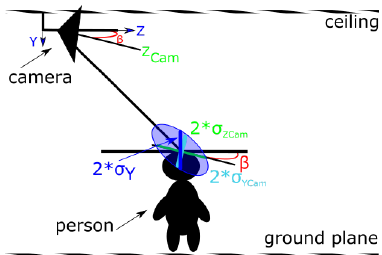
Figure 6. Illustration for the person height estimation error.